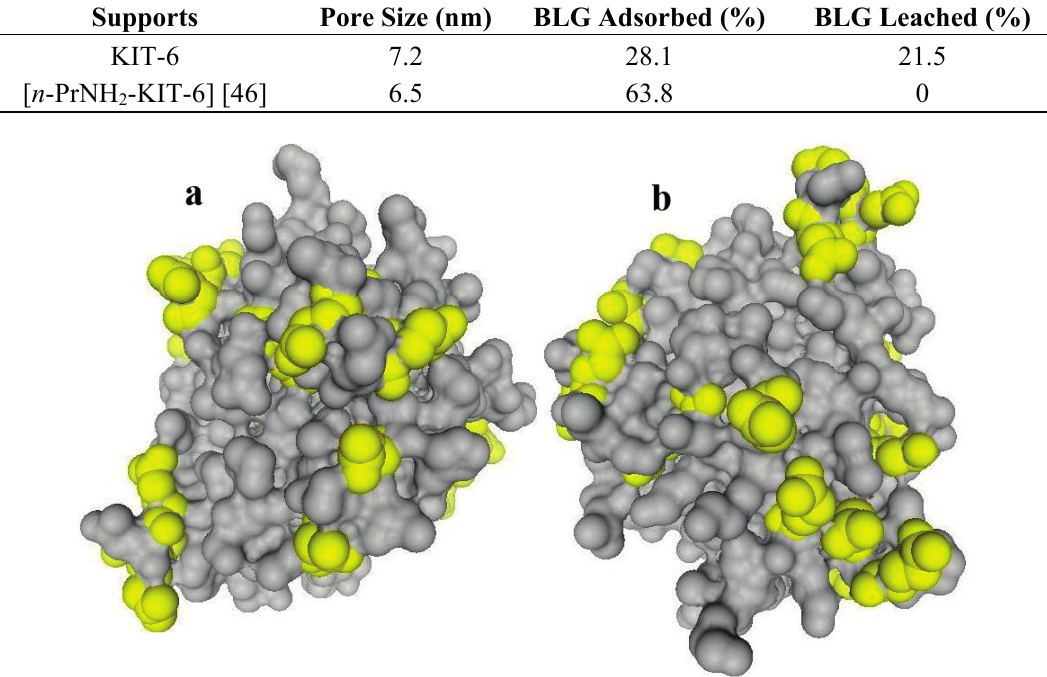
Figure 1. Distribution of carboxylic residues (yellow) on the BLG surface (PDB number: 3BLG) from two rotational views ( a , b ). This figure is generated by using the software of Swiss-PdbViewer version of